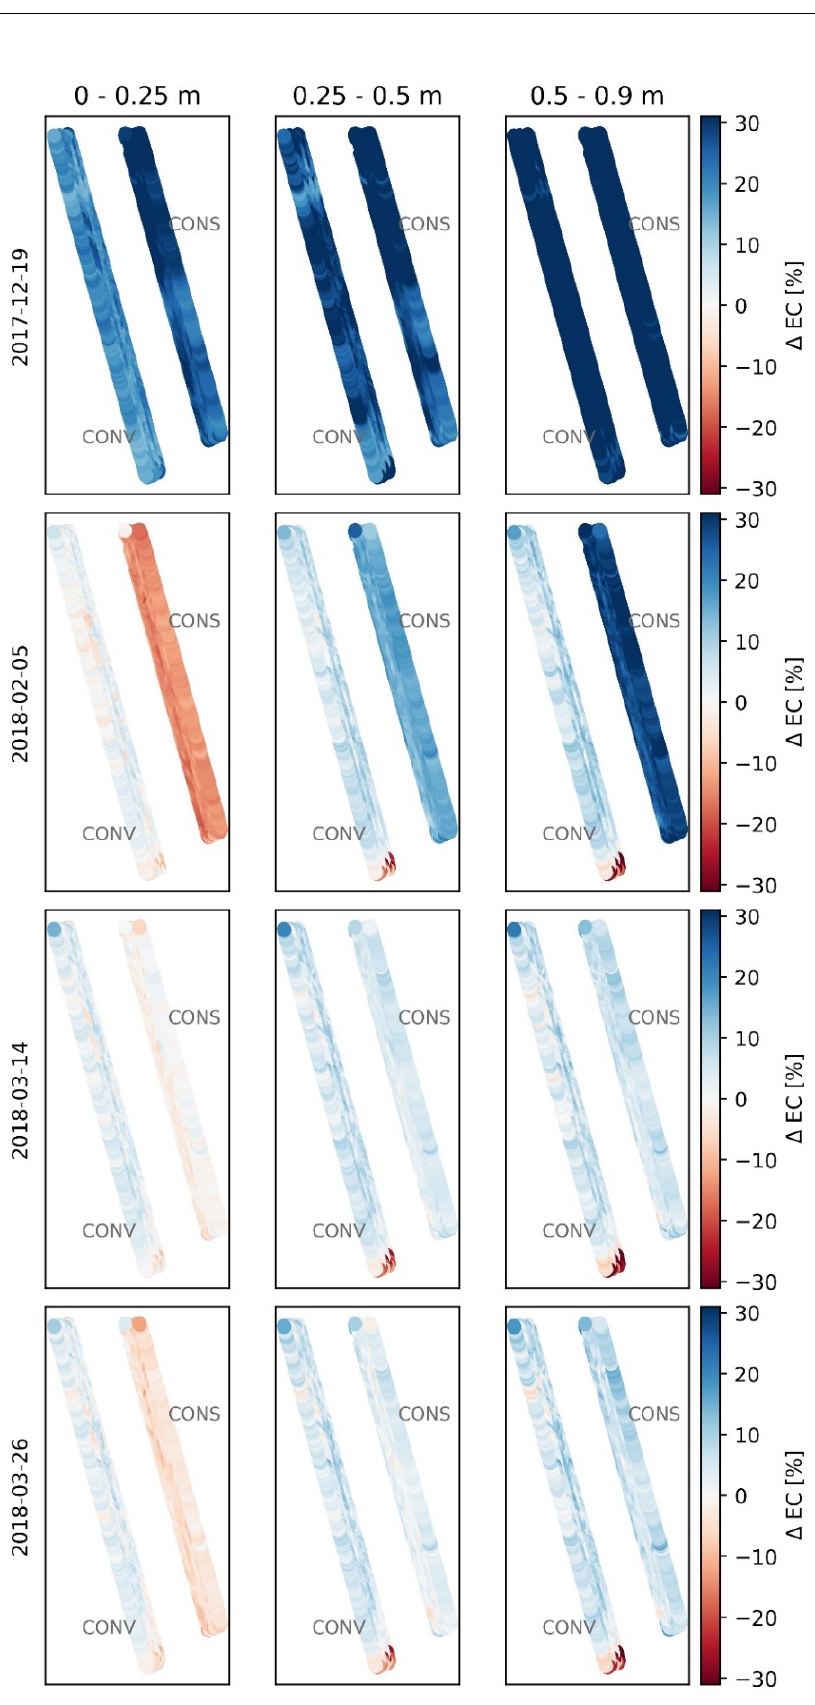
Figure 8. EMI inversion results: comparison of time-lapse EC differences between the two treat- ments.